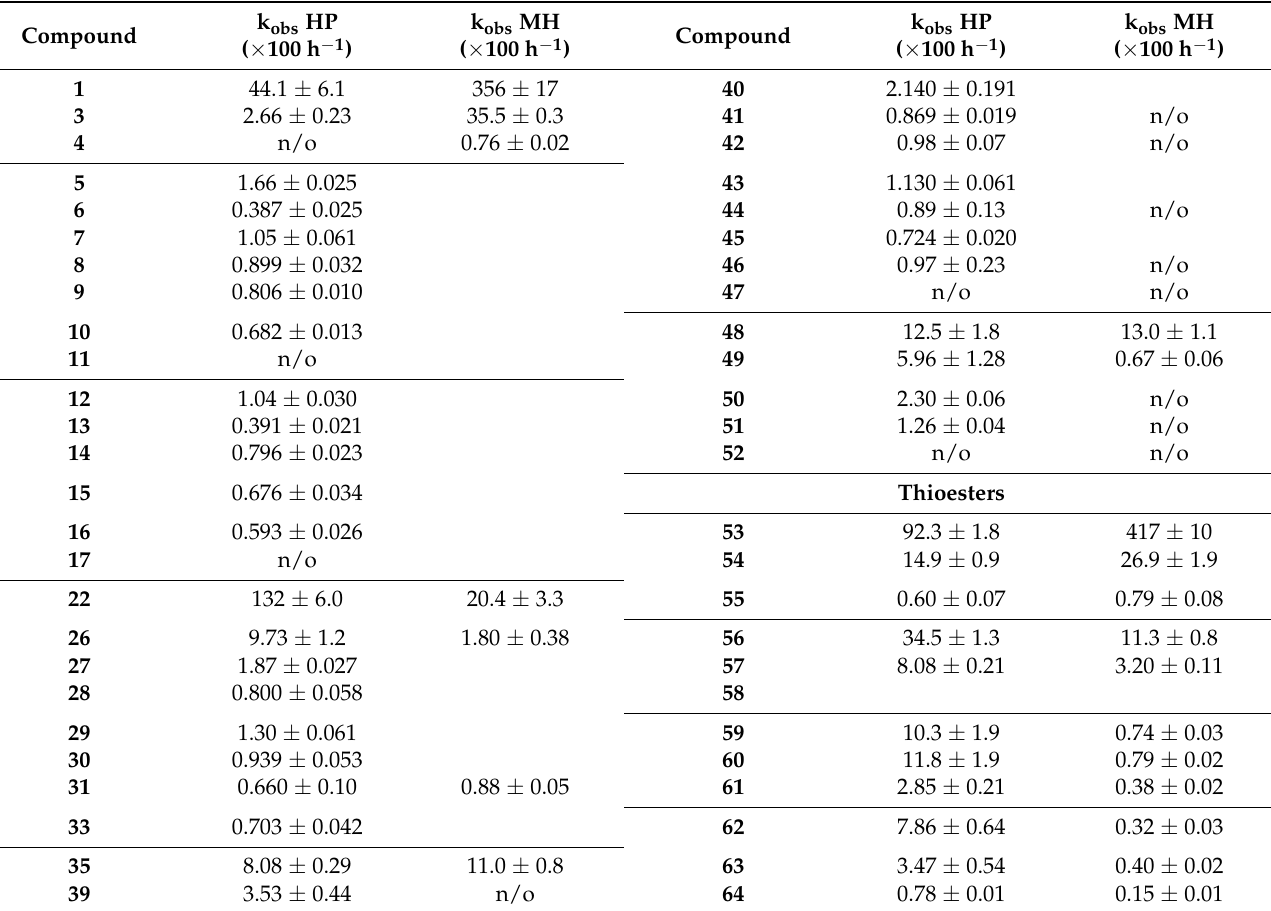
Table 4. Results obtained from stability studies in human plasma (HP) and mycobacterial homogenate (MH). Results presented as k obs ( × 100 h − 1